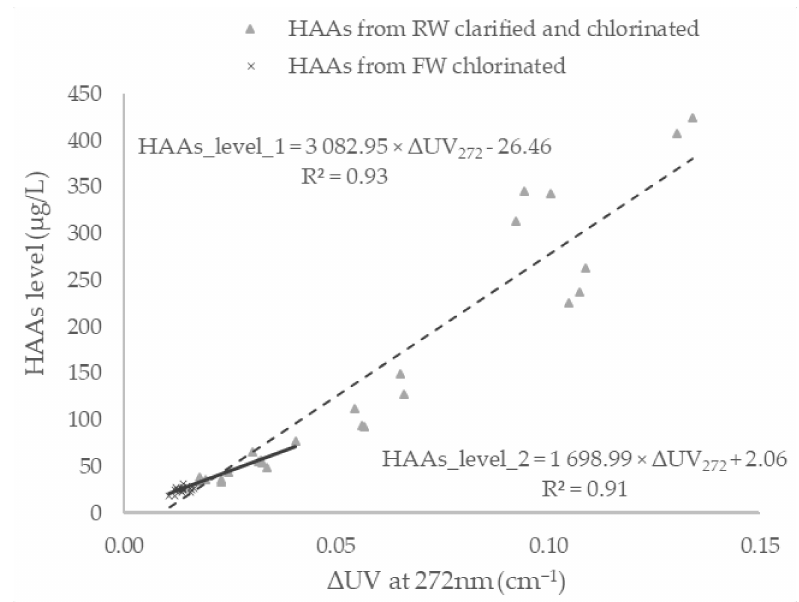
Figure 4. Correlation between haloacetic acid (HAA) levels and DUVA at 272 nm.